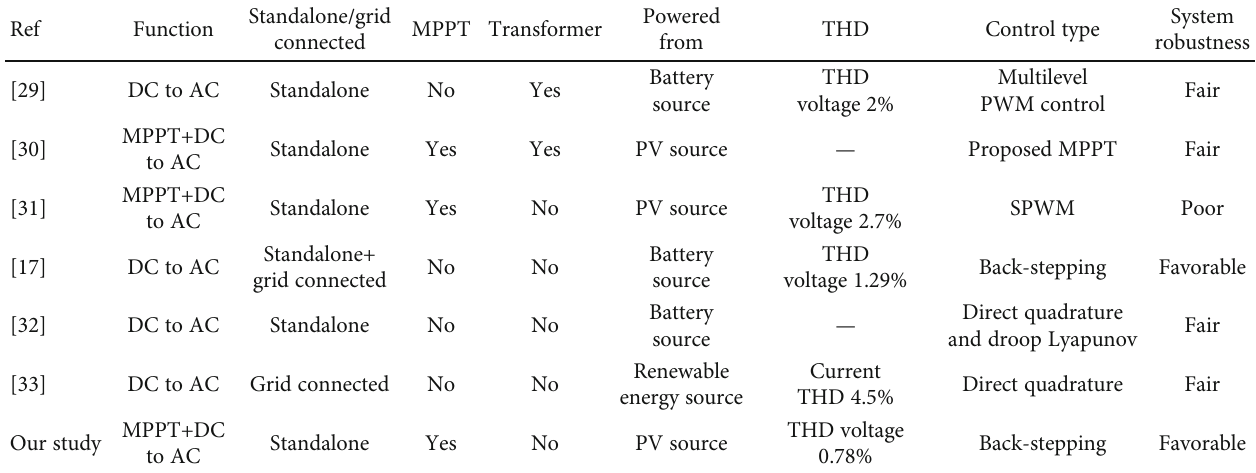
Table 5: Quality comparisons of the whole system with other proposal